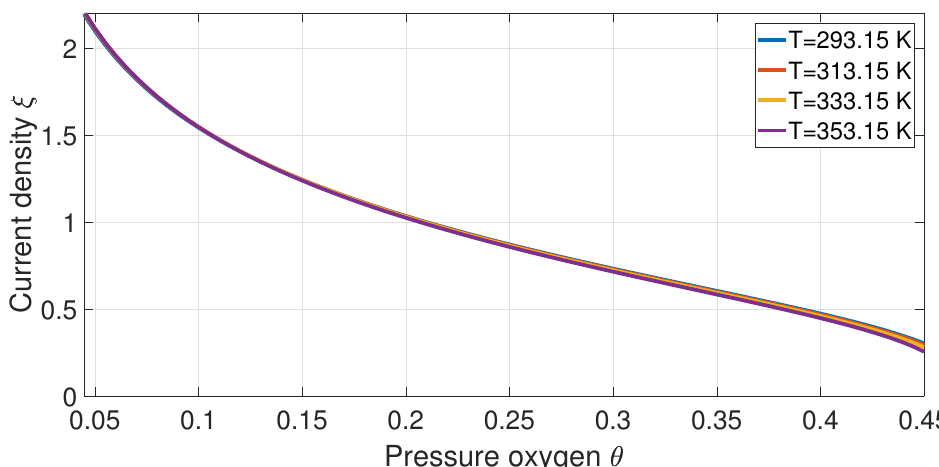
Figure 2. Behavior of the partial derivative of φ concerning θ .